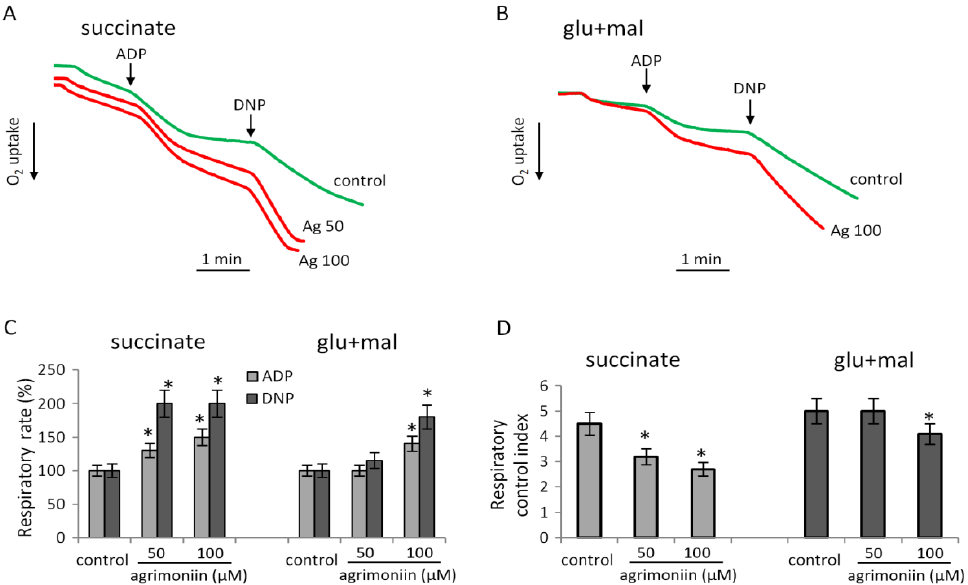
Figure 2. Influence of agrimoniin on respiration during oxidation of succinate and NAD-dependent substrates. Respiration supported by succinate (5 mM) oxidation ( A ) and glutamate (4 mM) plus malate (2 mM) oxidation ( B ) in control and in the presence of agrimoniin (50–100 µM); effect of agrimoniin in different concentrations on respiration rates in ADP (200) and DNP (50 µM) –stimulated states ( C ); respiratory control index ( D ). The respiratory control index was calculated as the ratio of respiration in the course and after ADP phosphorylation. Asterisk (*) indicates values that differ significantly from the control values ( p < 0.05).